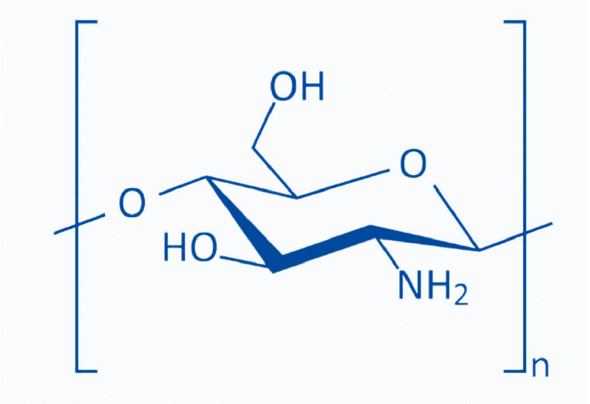
Figure 1. Basic chemical structure of N-deacetylated chitooligosaccharides. (Redrawn from the references: Liaqat and Eltem 2018 [3]; Naveed et al., 2019 [34]).